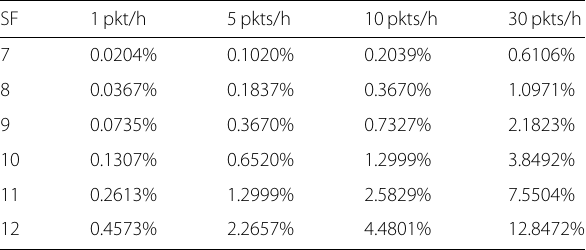
Table 3 Probability of collision, P ( col ) , for different spreading factors and packet generation